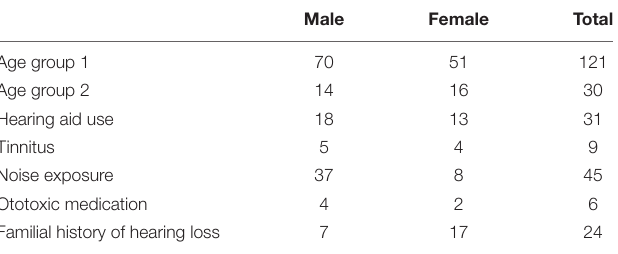
TABLE 1 | Demographic information of all participants and results of the standardized